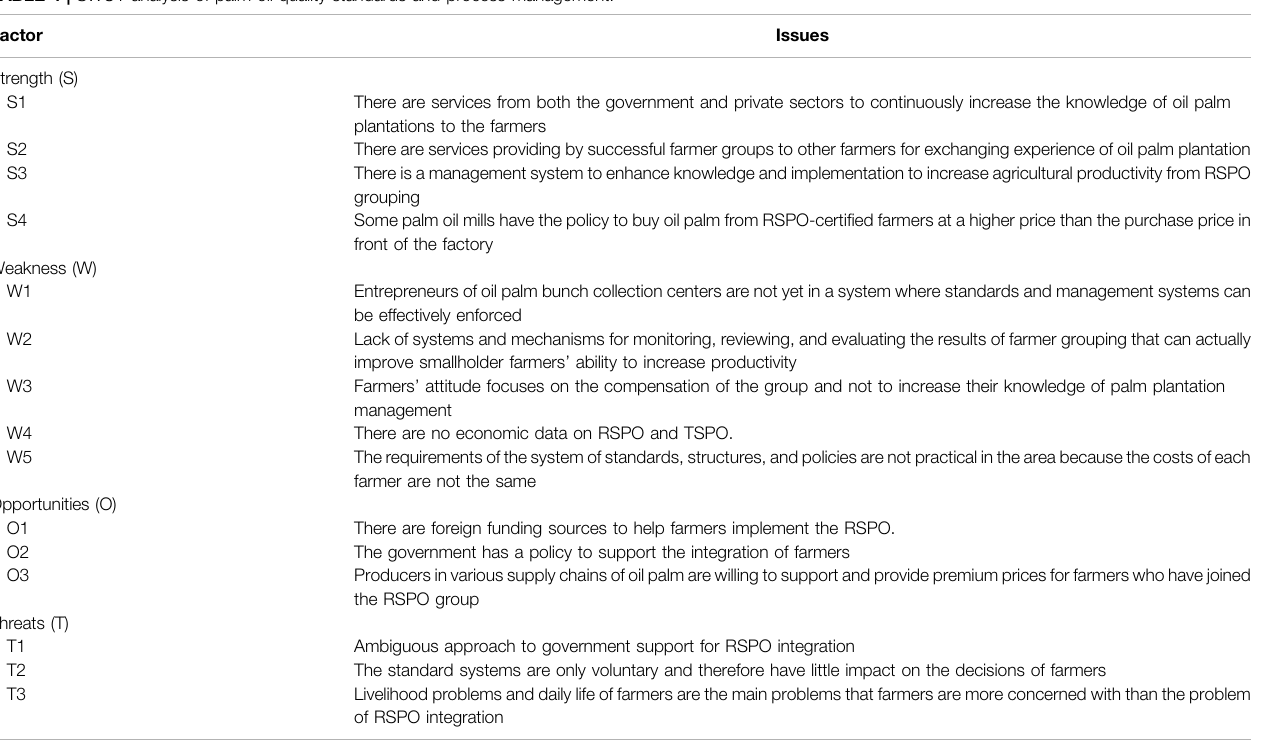
TABLE 4 | SWOT analysis of palm oil quality standards and process